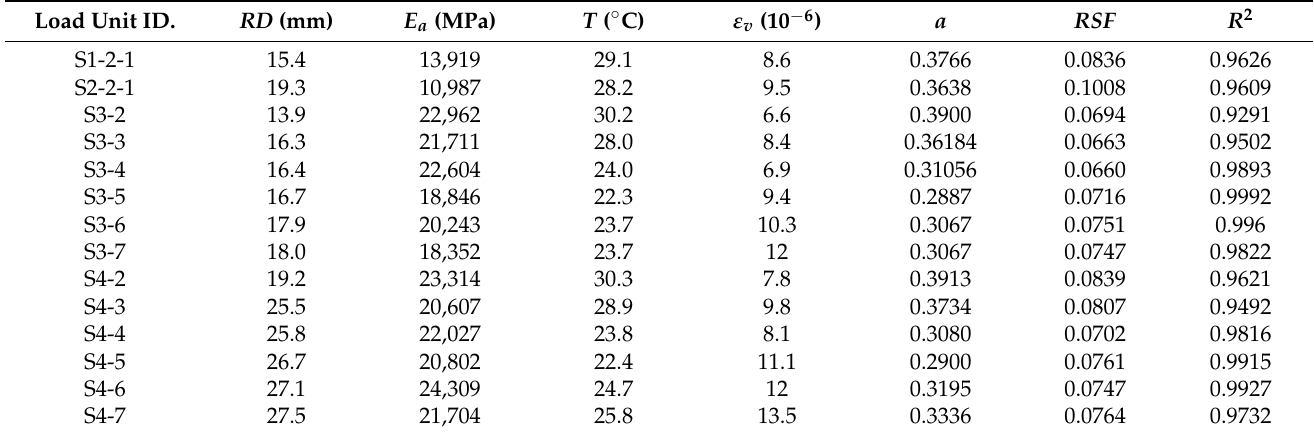
Table 5. Calculation results of the parameters used for the model calibration and model regression results of the different load